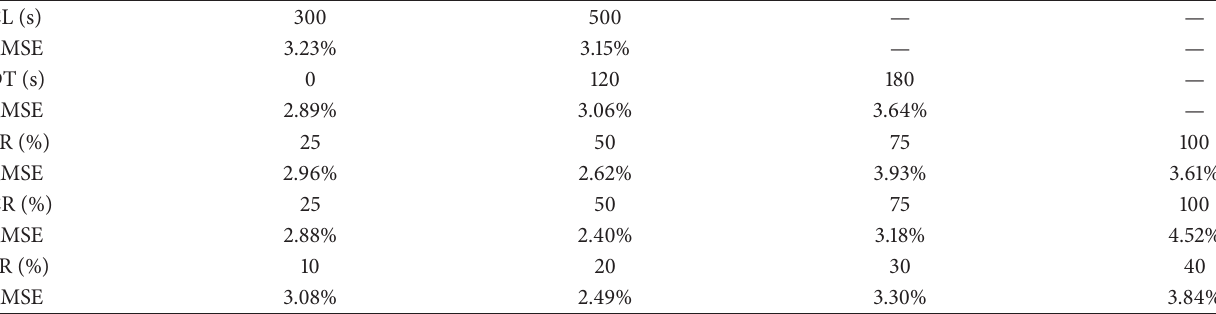
Table 3: Influence of CV characteristics indexes on prediction